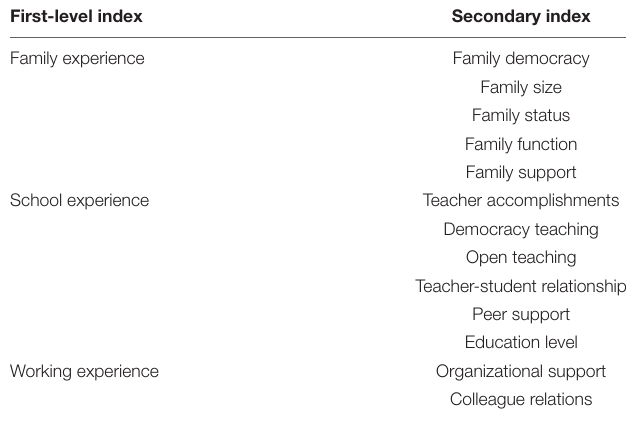
TABLE 1 | Indexes about early growth experiences of original innovation